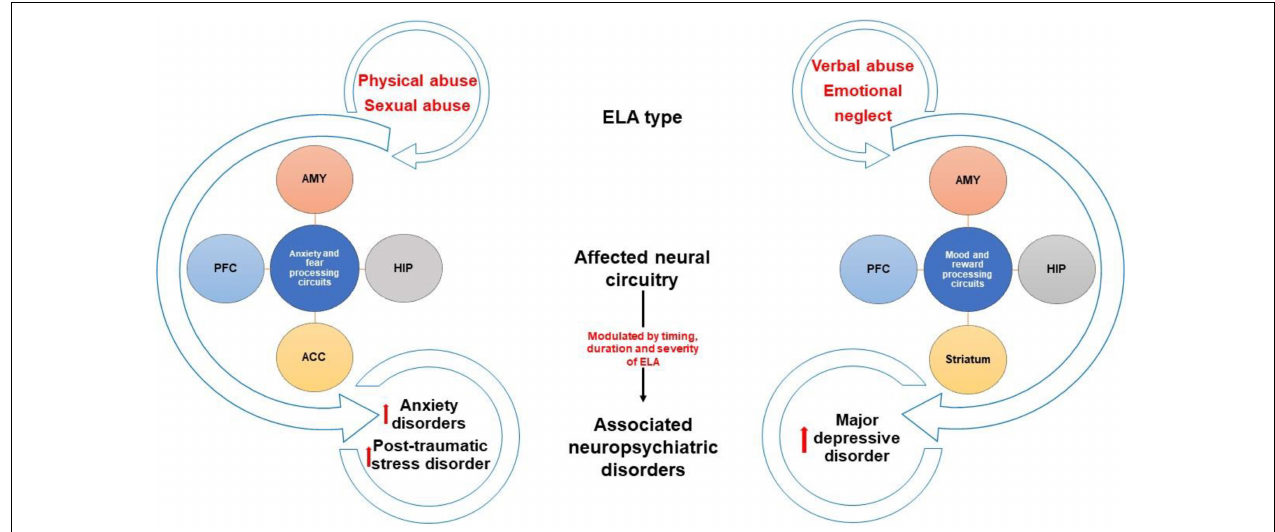
FIGURE 1 | Brain changes and neuropsychiatric outcomes associated with different ELA types. Diagram depicting brain regions that are altered by different types of childhood maltreatment. Studies show that physical and sexual abuse can alter regions involved in anxiety/fear processing circuits while verbal abuse and emotional neglect affect regions related to mood/reward processing circuits. These brain changes likely contribute to differential predisposition to certain neuropsychiatric disorders, such as anxiety disorders, post-traumatic stress disorder, and major depressive disorder. ACC, anterior cingulate cortex; AMY, amygdala, HIP, hippocampus, PFC, prefrontal